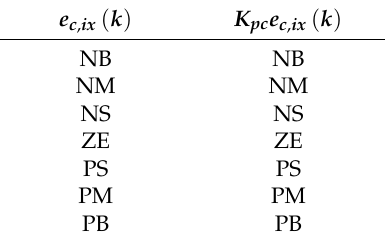
Table 1. Fuzzy rules of the Fuzzy-P current